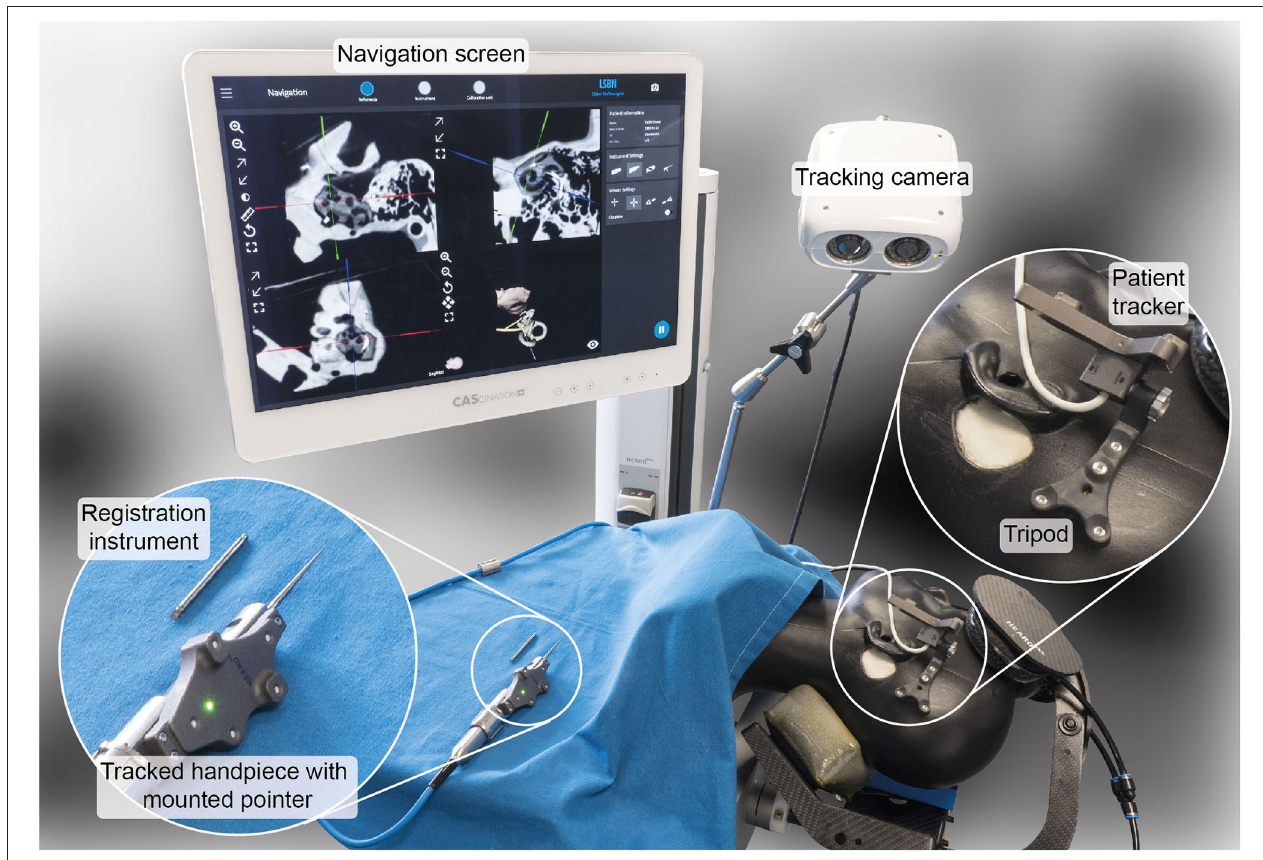
FIGURE 1 | Freehand stereotactic image-guidance system tailored to neurotologic surgery. It comprises a spatial tracking camera, a tracked handpiece providing the possibility to track a registration and pointer instrument, a bone-anchored tripod embedding four titanium registration fiducials and providing an interface to attach the patient tracker, and a navigation user